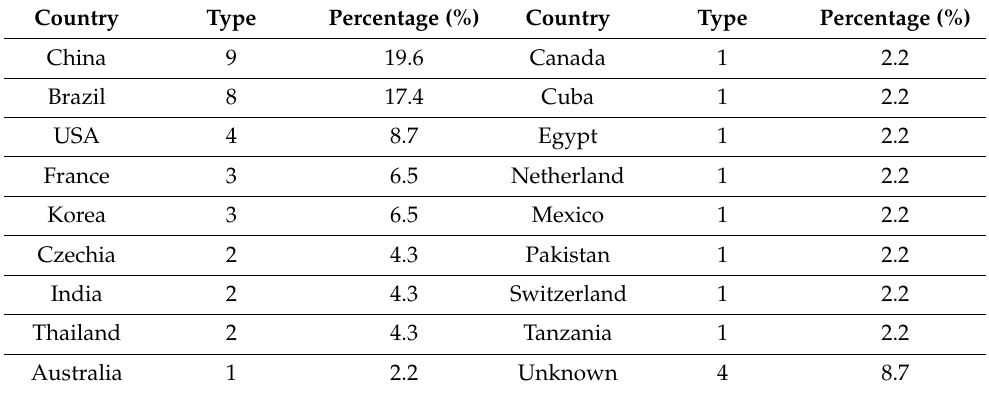
Table 1. The origin of taxonomic types in Absidia